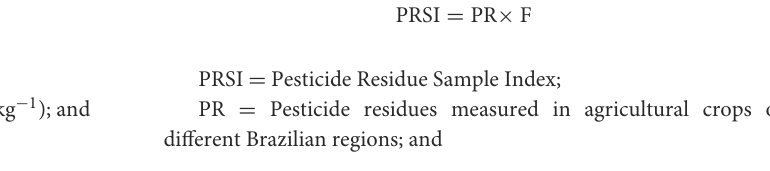
MRL = Maximum Residue Limits (in ppm or mg.kg − 1 );